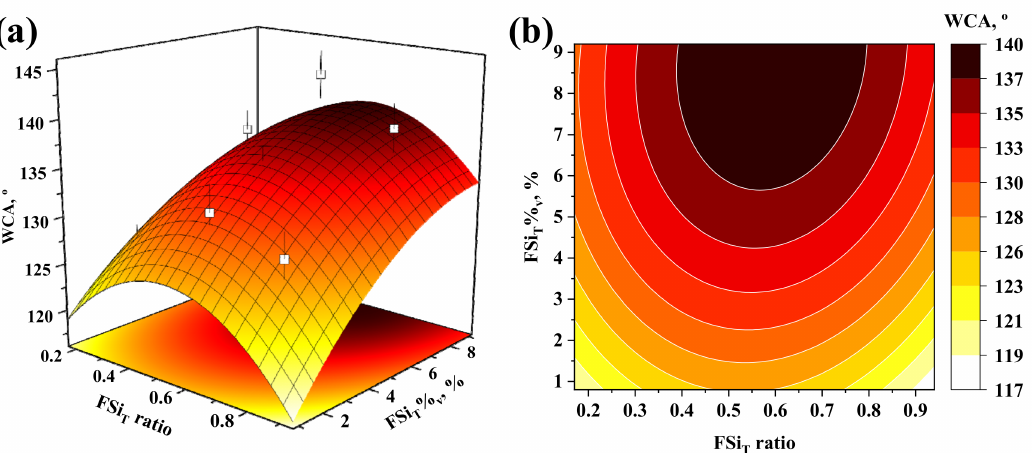
NaOH% wt of 5% in Figure 5.